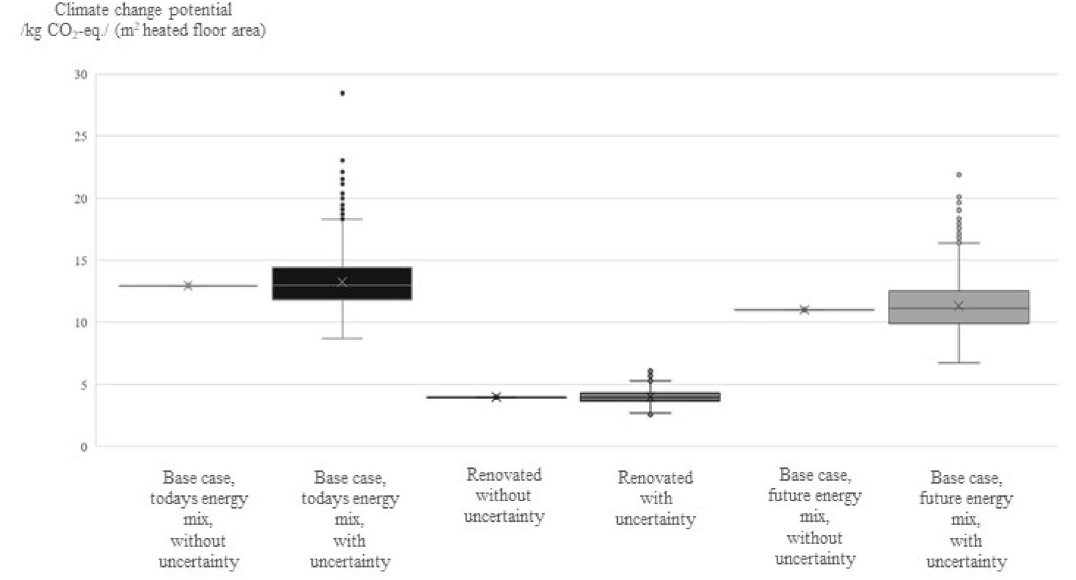
Fig. 5 simulation results for the climate change potential due to the addition of 280 mm of glass wool in the attics. The results are shown with and without consideration of uncertainties in the input data and with two different scenarios for the energy